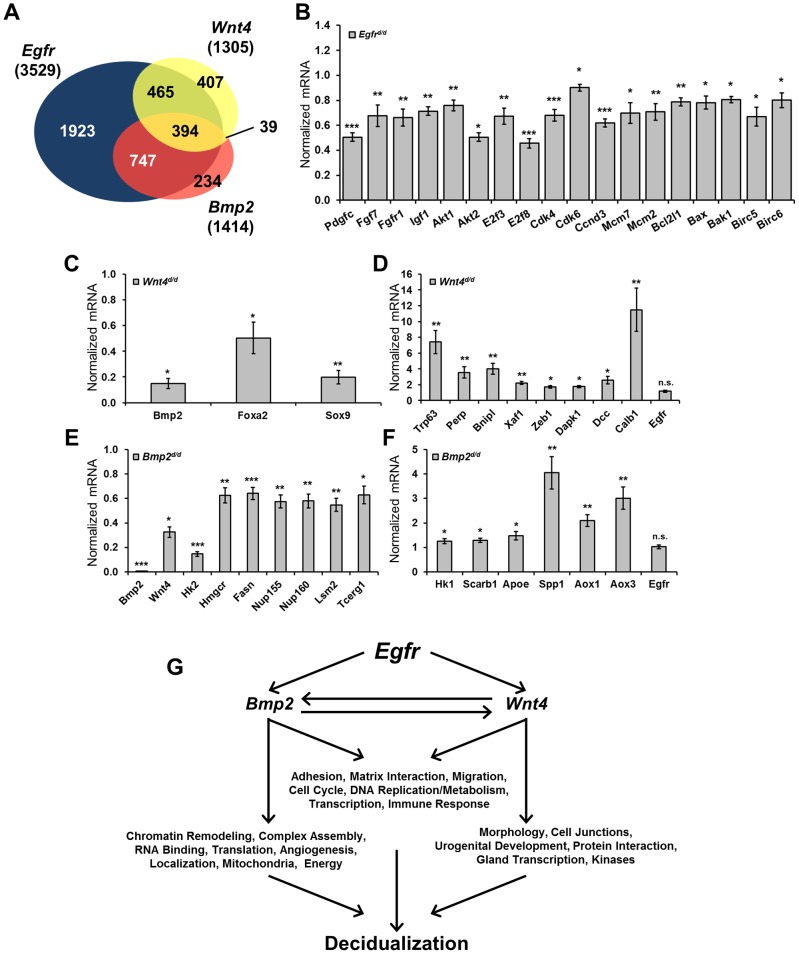
Decidual microarrays reveal BMP2 and WNT as EGFR mediators.(A) Venn diagram comparing gene expression signatures from Egfr, Bmp2 and Wnt4 conditional knockout day 1 decidual uteri. (B–F) Quantitative real-time PCR validation of microarray results using independent samples, normalized to control expression. (B) Validation of genes altered in the absence of Egfr. (C) Validation of genes with reduced expression and (D) elevated expression in Wnt4 uteri. (E) Validation of genes with reduced expression and (F) elevated expression in the absence of Bmp2. (G) Model depicting which cellular processes and gene ontologies are deregulated in the respective mouse models as determined by DAVID analysis.